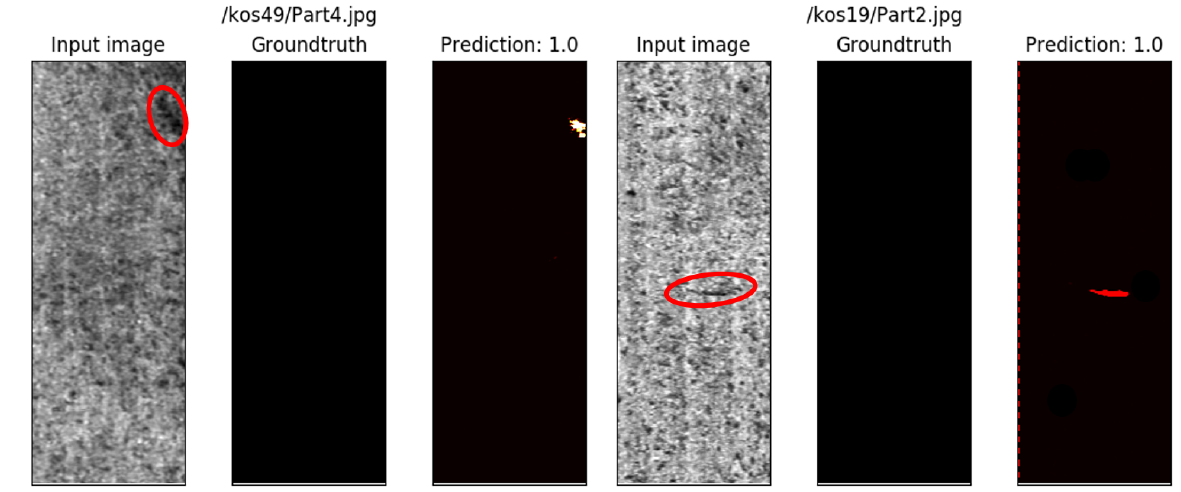
Figure 13. Examples of FP in KolektorSDD.